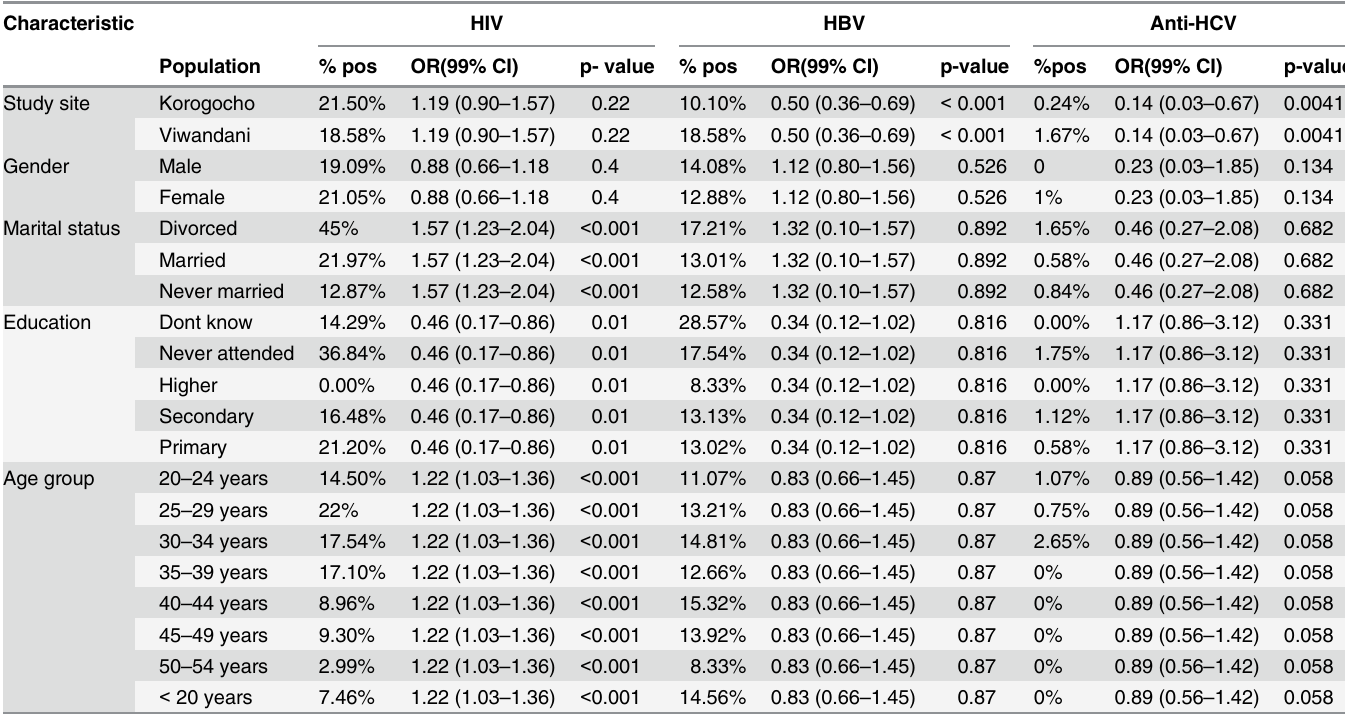
Table 2. Prevalence rates of HIV, HBV and